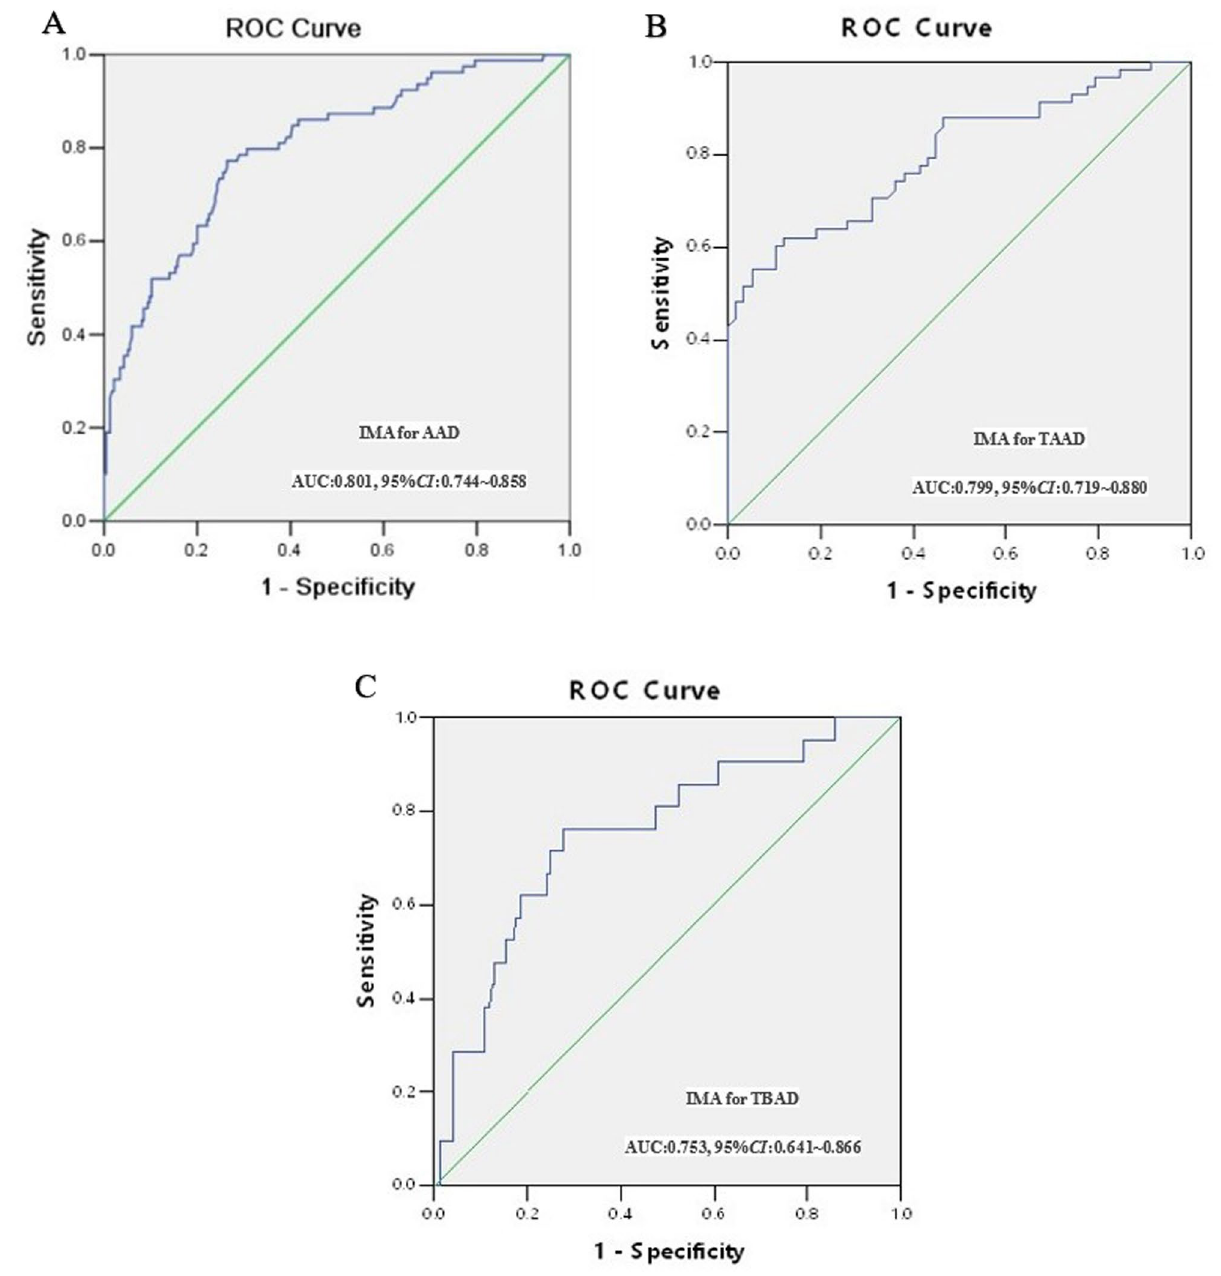
Figure 3. AUC value of IMA for predicting in-hospital mortality in patients with different types of AAD. IMA, Ischemia-modified albumin; AAD, acute aortic dissection; TAAD, Stanford type A aortic dissection; ROC, Receiver operating characteristic; AUC, area under the curve.